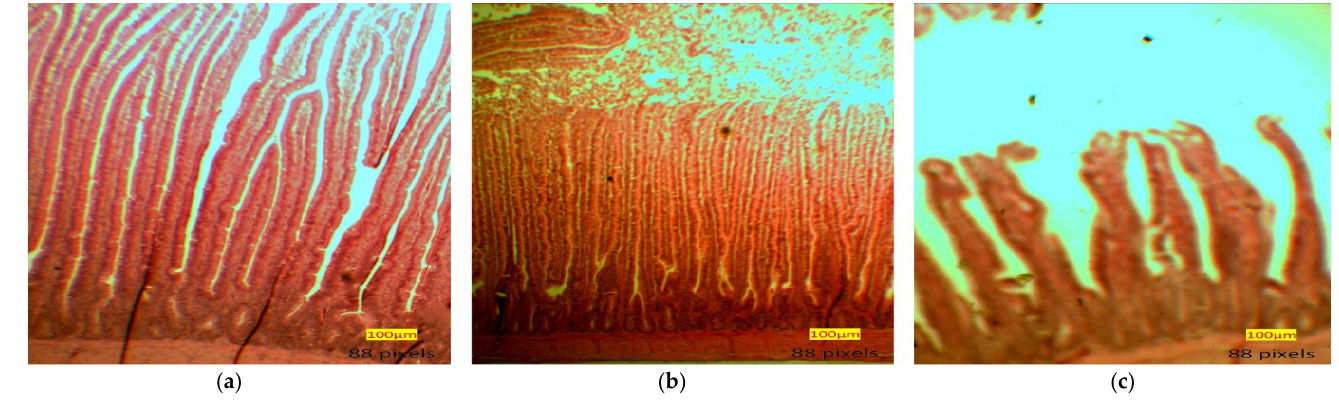
Figure 1. ( a ) Duodenum, ( b ) Jejunum, ( c ) Ileum villi heights and crypt depth of small